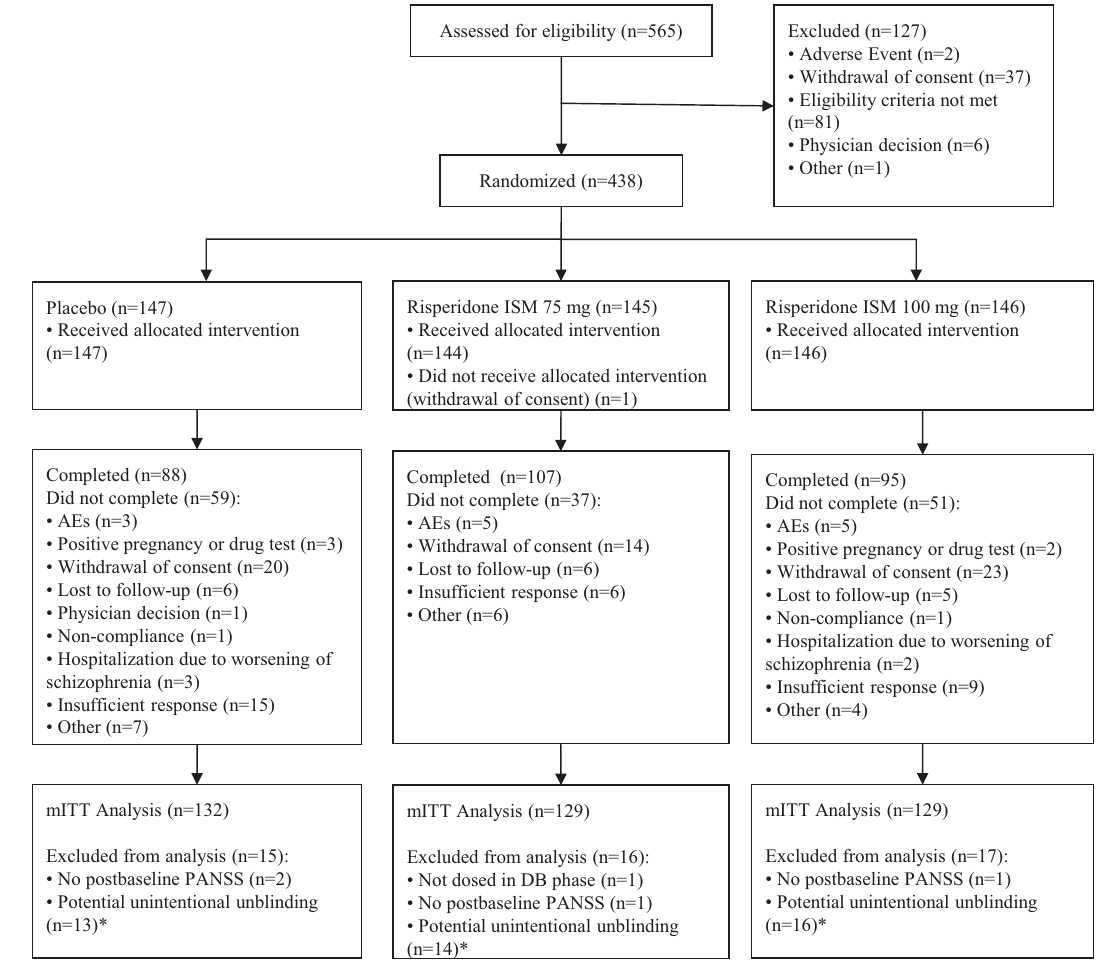
Fig. 1 Patient disposition. Where patients marked with “ * ” were included in the ITT analyses (ITT: Intention-to-Treat; mITT: modi fi ed